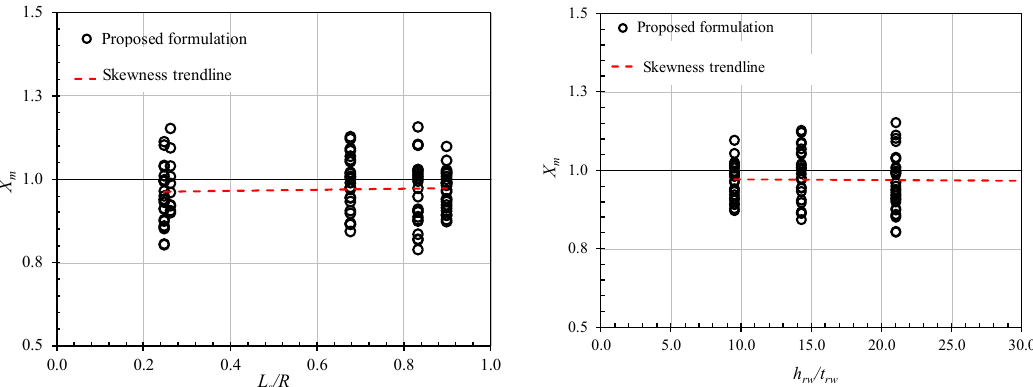
Figure 25. Skewness of the proposed formula against the basic parameters L s /R and h rw /t rw for the stringer-stiffened cylinder.